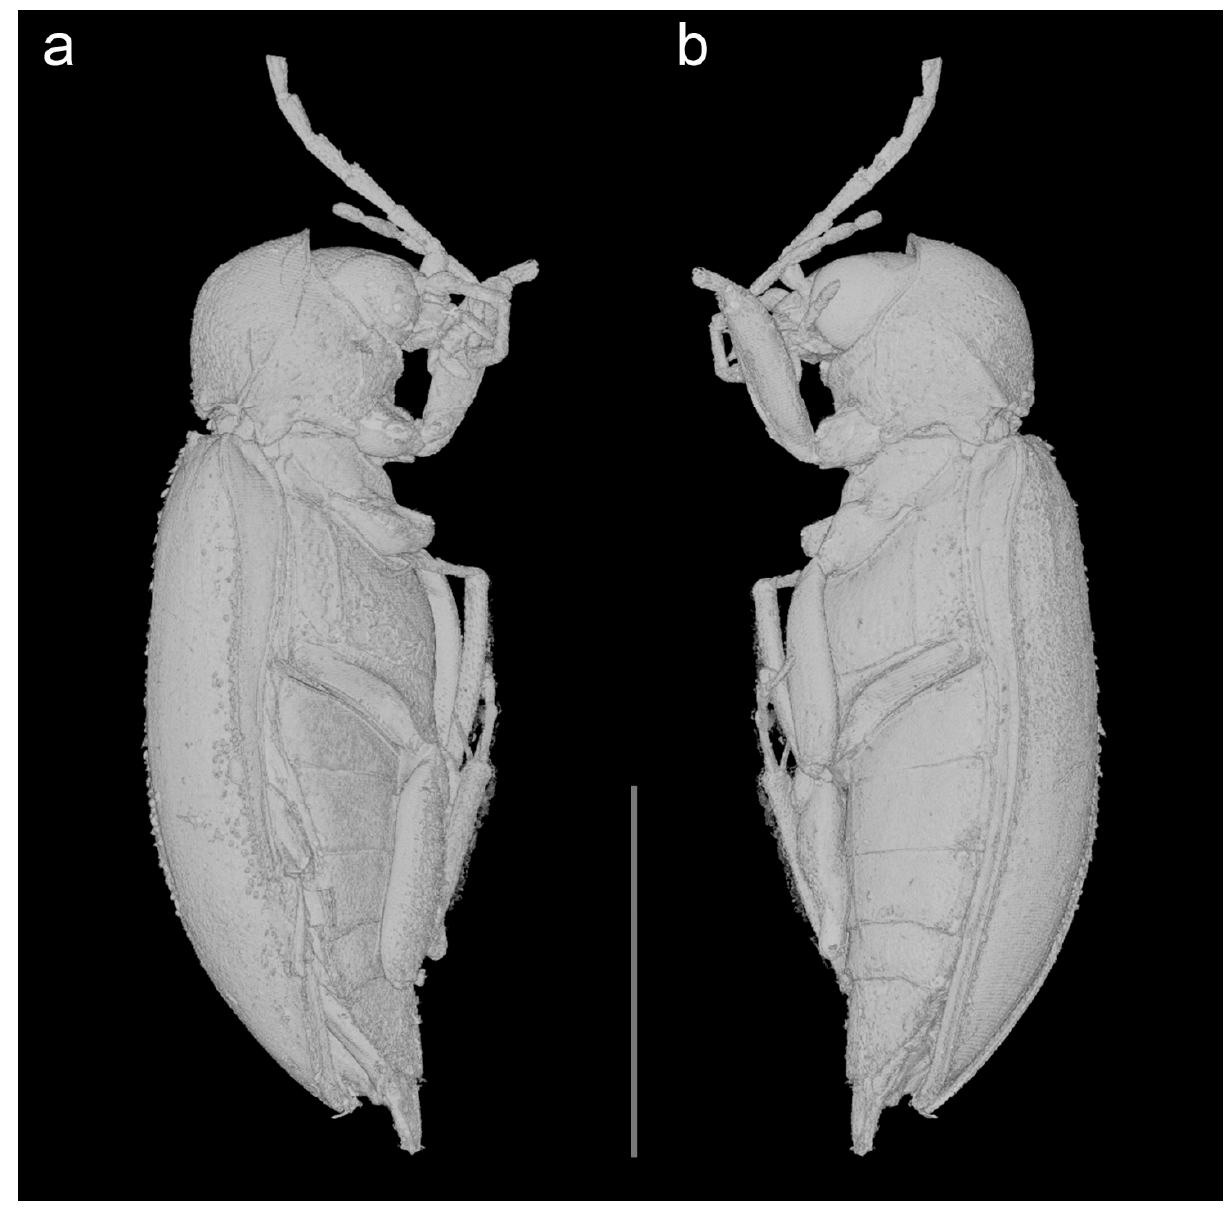
Figure 4. Ptilodactyla eocenica Kundrata, Bukejs and Blank, sp. nov., habitus. ( a,b ) Lateral views. Scale bar = 4.0 mm.